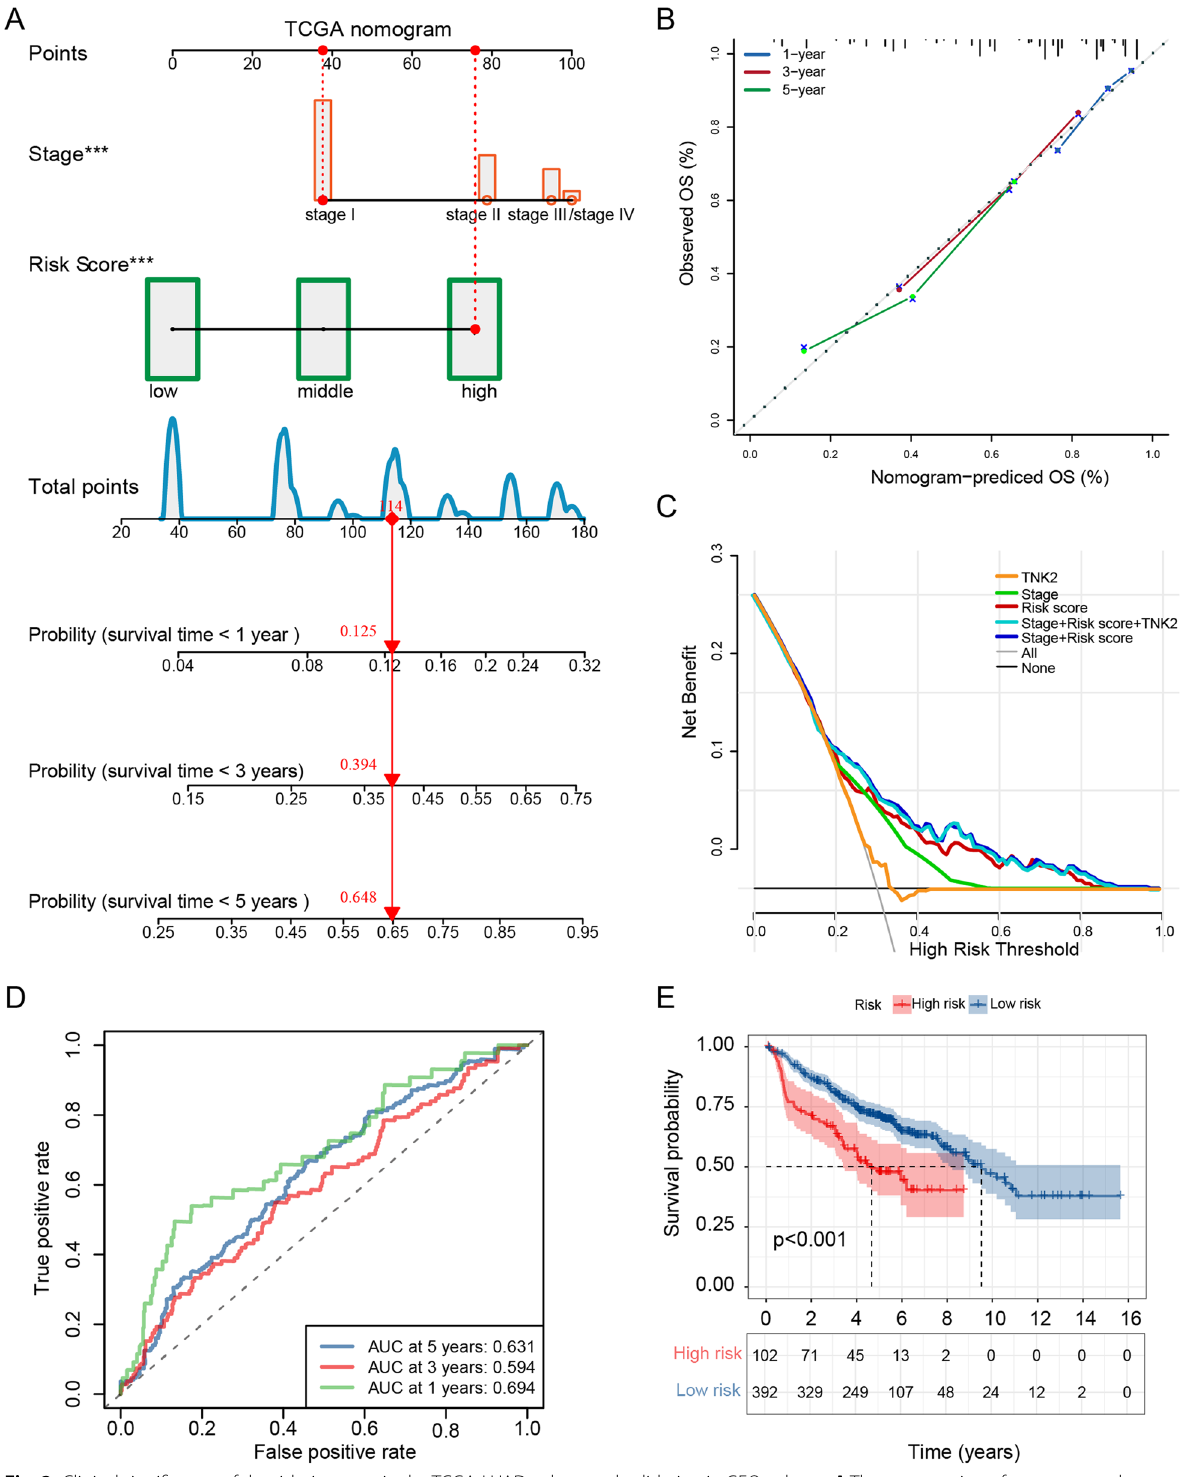
Fig. 2 Clinical significance of the risk signature in the TCGA-LUAD cohort and validation in GEO cohorts. A The construction of a nomogram by integrating risk score and clinical stage. B The calibration plots compare the observed (y-axis) and predicated (x-axis) 1-, 3- and 5-year survival. C Decision curve analysis revealed that the combination of the risk score and TNM stage improved net benefit at any given threshold. The predicting accuracy of the 23-gene signature was tested in 495 patients with LUAD collected from GSE31210, GSE37745, and GSE50081 cohorts, by plotting ROC ( D ) and Kaplan–Meier survival curves ( E